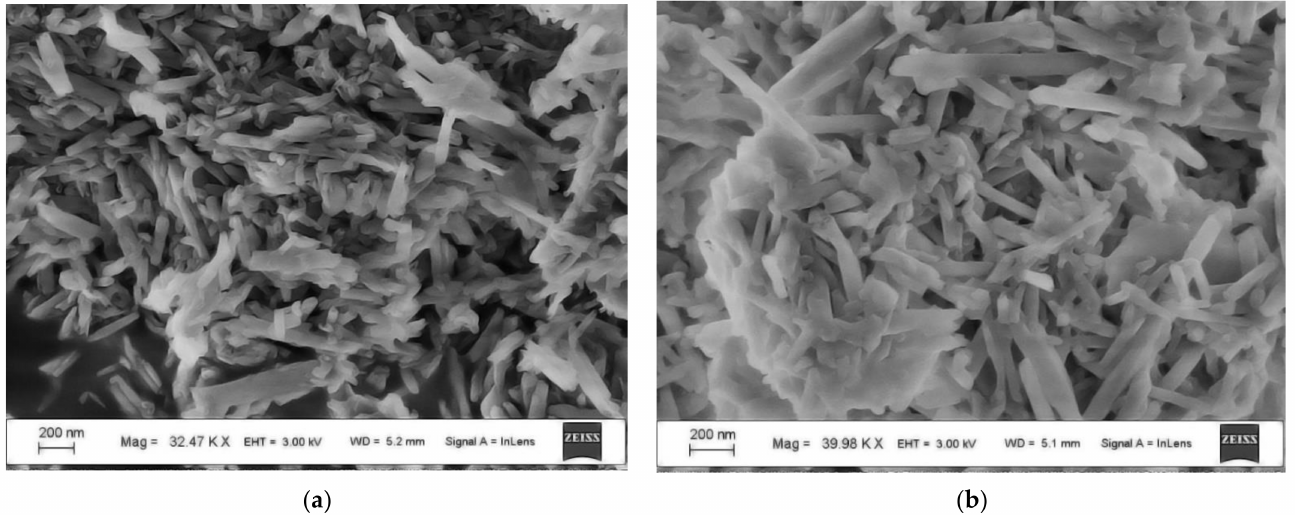
Figure 4. SEM image of unmodified HNT ( a ) and modified HNT sample ( b